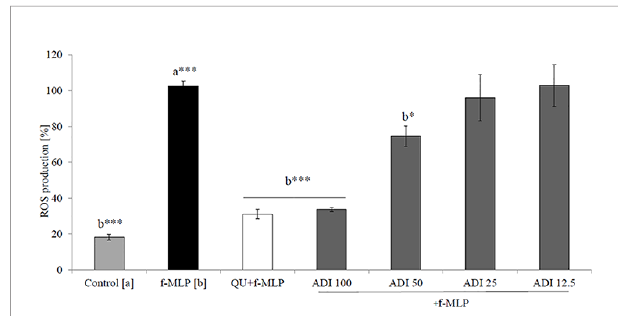
FIGURE 2 | Effect of the ADI at concentrations of 12.5-100 µg/mL on ROS production by f-MLP-stimulated neutrophils [%], mean ± SEM. Positive control quercetin (QU) at a concentration of 20 µM. Statistical signi fi cance of differences was established by ANOVA with post hoc test, *p < 0.05 ***p < 0.001, a*** - statistical signi fi cance of differences between f-MLP stimulated control compared control, b - compared to the to the stimulated control